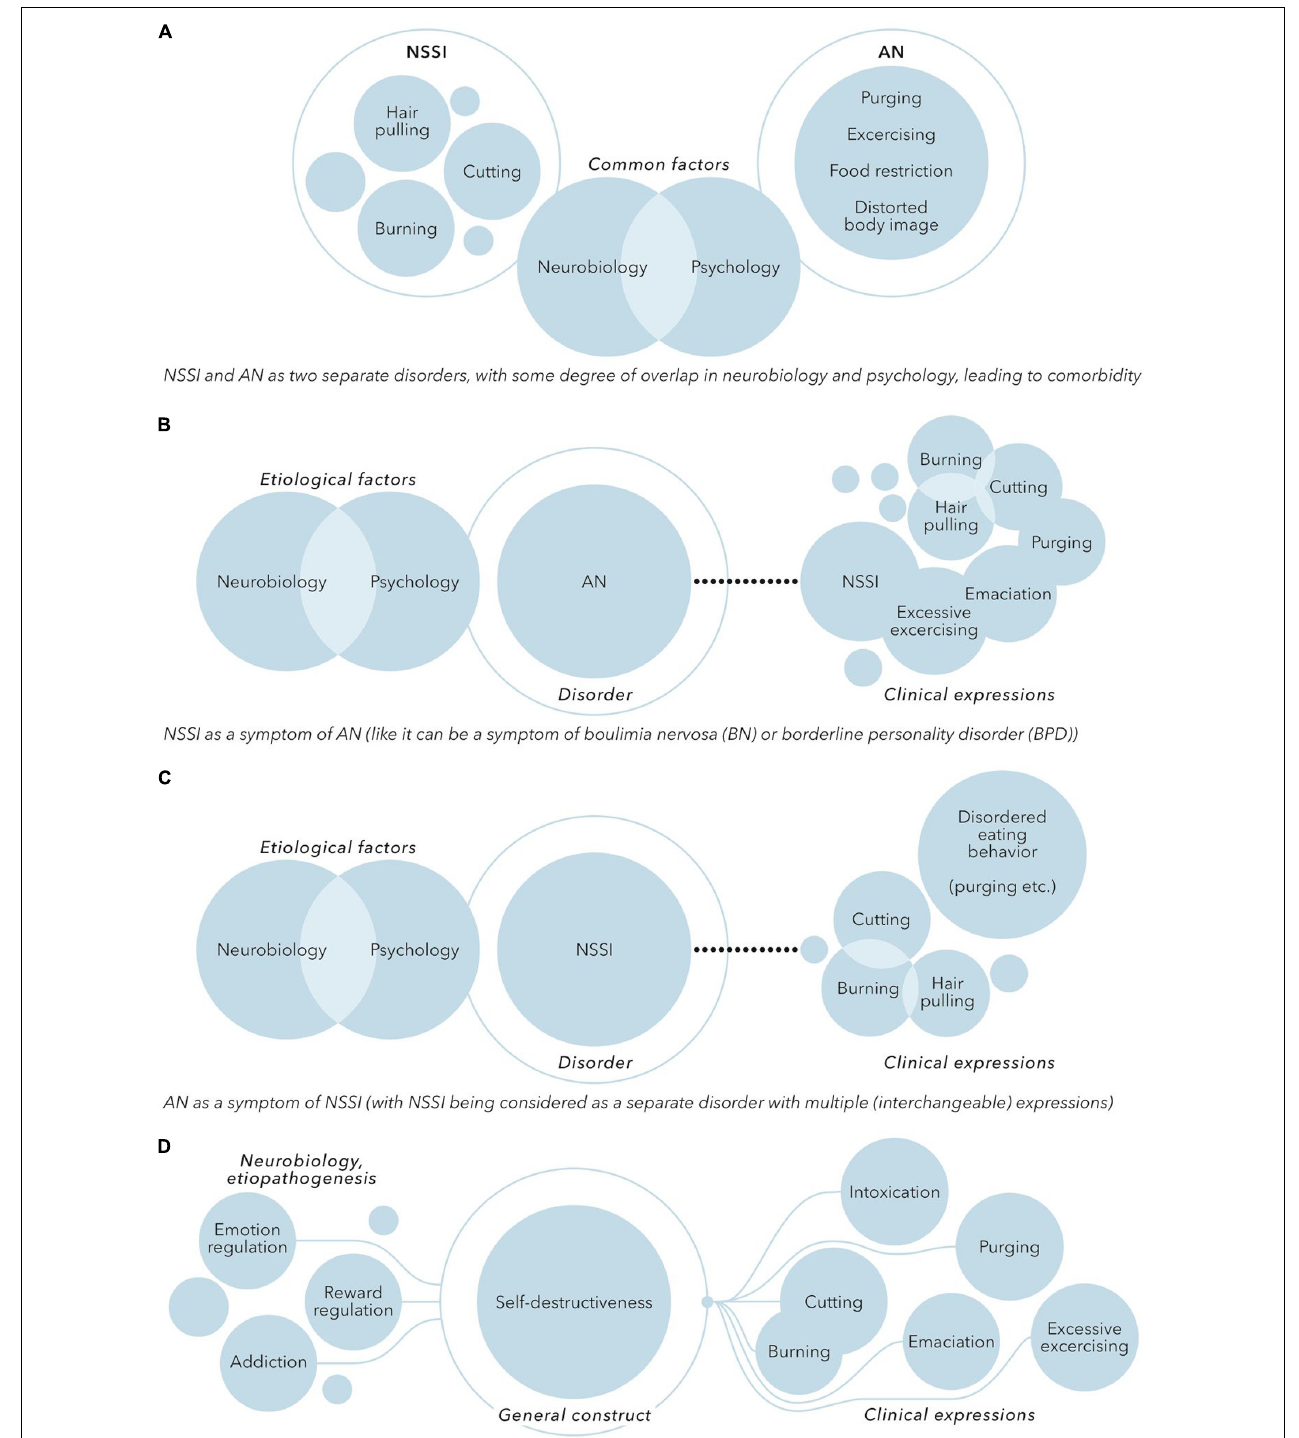
Frontiers in Psychiatry |